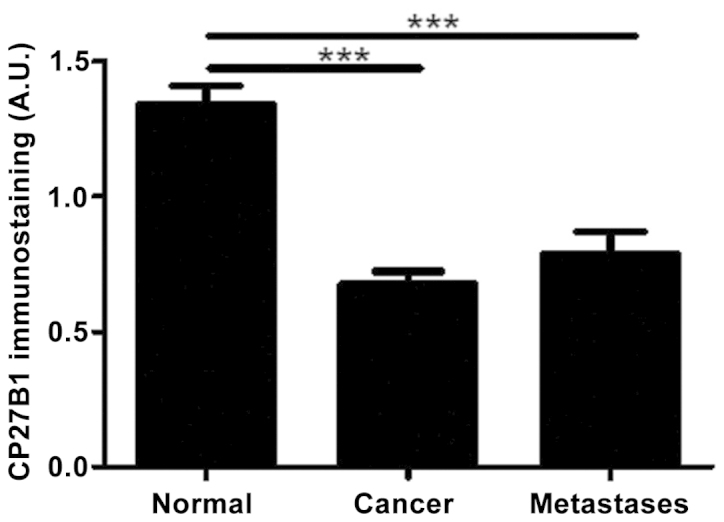
CYP27B1 immunostaining is inversely associated with cancer progression. Statistically significant differences are denoted with asterisks by ANOVA ***p<0.001 with ANOVA. A.U., arbitrary units.